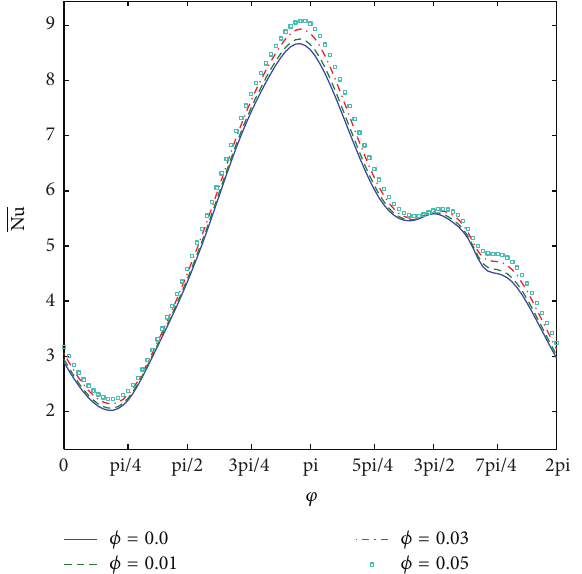
Figure 8: Plots of the average Nusselt number against 𝜑 for the values of 𝜙 labeled on the figure with Ta